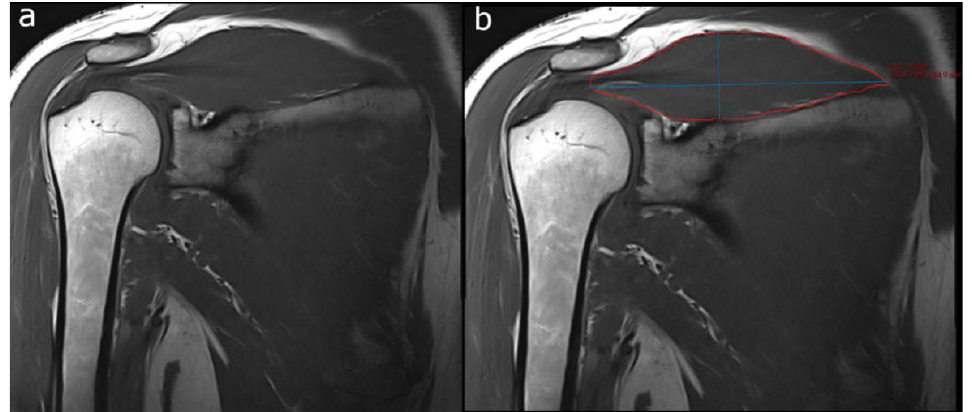
are traced (red outline) on each image slice and automated 2D measurements (largest long axis di-